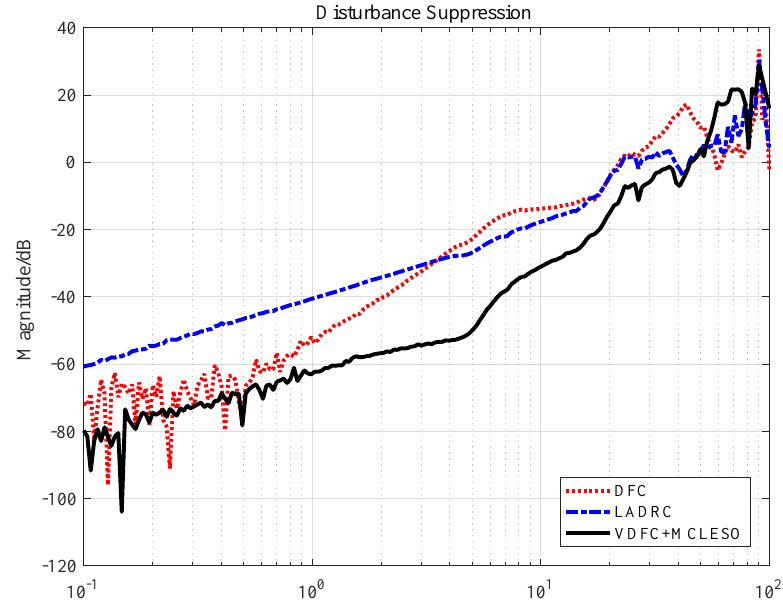
Figure 9. Disturbance suppression ability of traditional DFC, classical LADRC and VDFC with